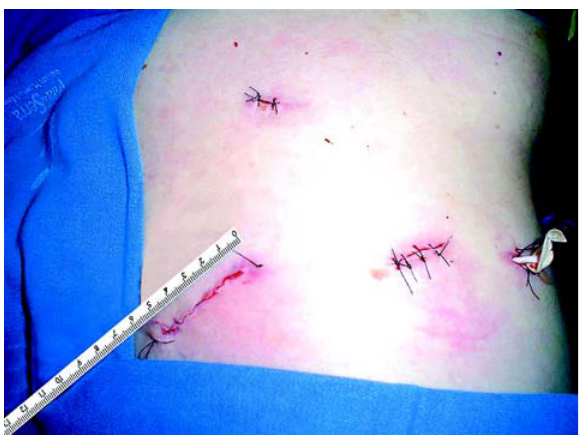
Figure 3 – Final aspect of the incisions. The specimen was re- moved by the 5 cm inguinal incision. A Penrose drain is left in the dorsal surgeon working port.